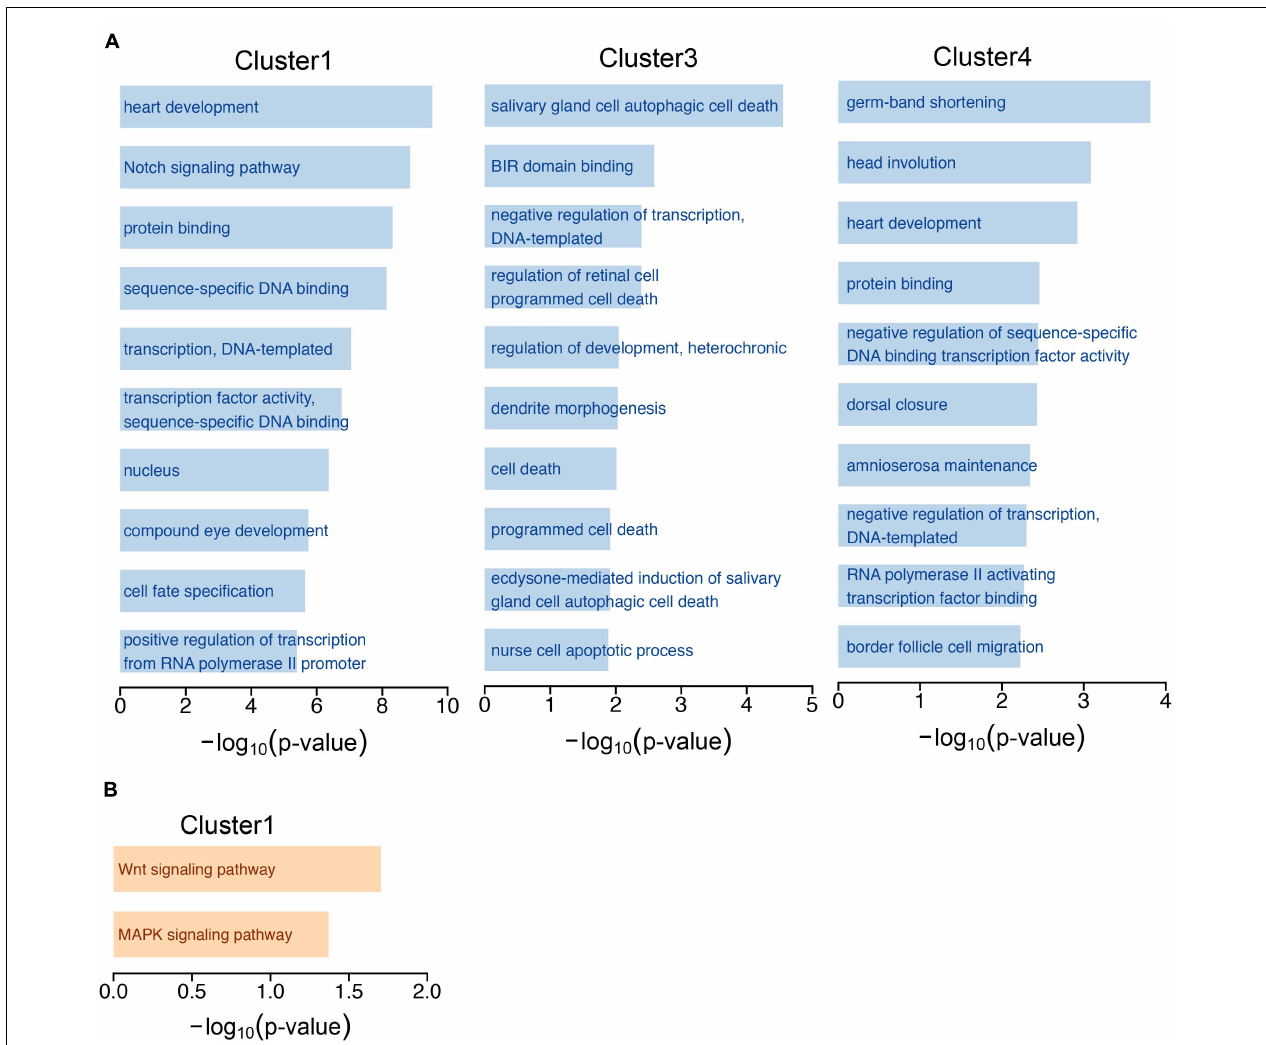
FIGURE 2 | GO annotation and KEGG pathway analysis. (A) The top 10 GO terms of experimentally validated targeted genes of miRNAs in the 4 clusters. (B) Pathway analysis of targeted genes of cluster 1 miRNAs by